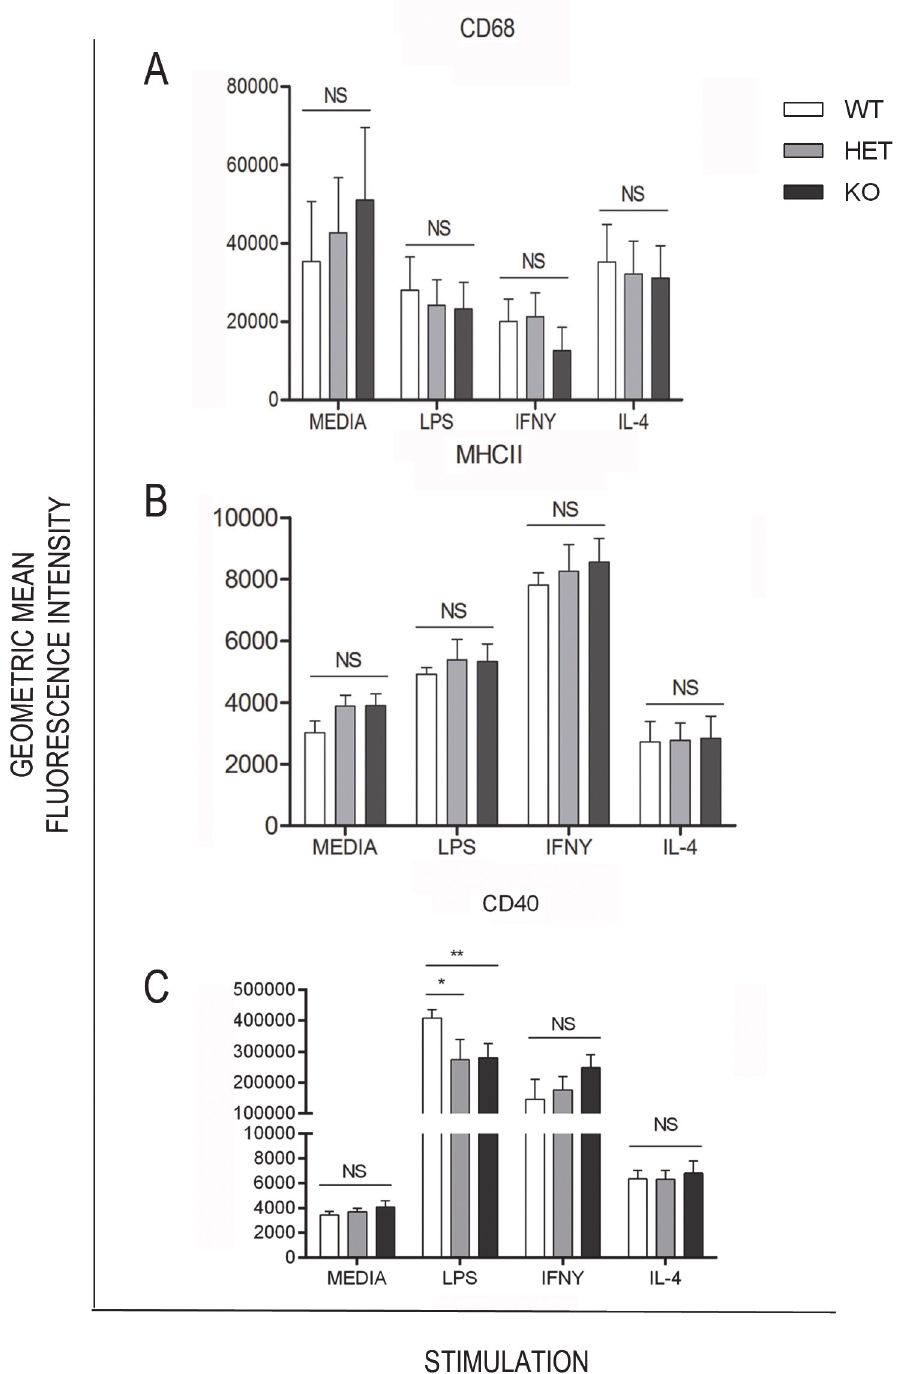
Fig 4. Flow cytometric analysis of BMDM phenotype from cells cultured for 24 hours in the presence of a panel of cytokines. Geometric mean fluorescence intensity values for A) intracellular CD68 expression (n = 4), B) cell surface MHCII expression (n = 3) and C) cell surface CD40 expression (n = 5) * p < 0.05 ** p < 0.01 *** p <